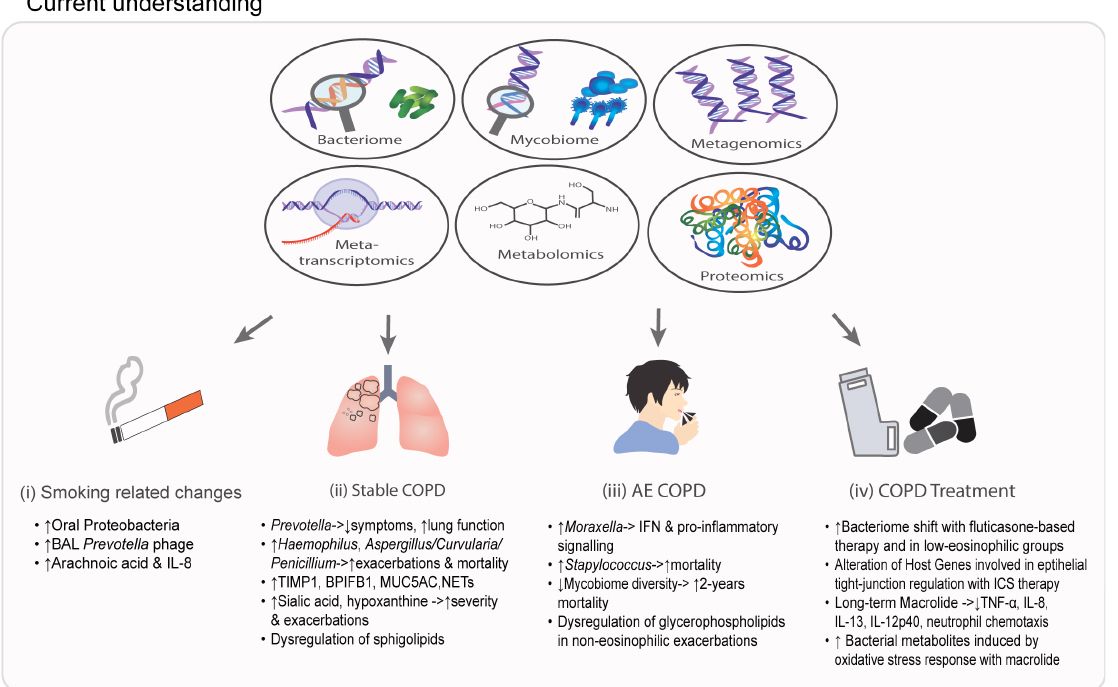
Figure 1. A pictorial summary of the current literature in relation to the application of next- generation sequencing (NGS) and multi-omic analysis in (i) smoking-related change [12,13,14], (ii) stable COPD [15,16,17,18,19,20,21,22], (iii) acute exacerbations of COPD (AE COPD) [16,23,24,25], and (iv) COPD treatment [26,27,28]. BAL: bronchoalveolar lavage, IL: interleukin, TIMP1: metalloproteinase-inhibitor 1, BPIFB1: bactericidal/permeability-increasing fold-containing family B member 1, MUC5AC: mucin 5AC, NETs: neutrophil extracellular traps, IFN: interferon, TNF: tumor necrosis factor, ↑ : increase, ↓ :